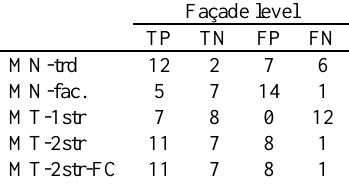
Table 3. True Positives (TP), True Negatives (TN), False Positives (FP) and False Negatives (FN) when evaluating the models at a facade level. 27 façades are considered in validation (19 damaged and 8 not